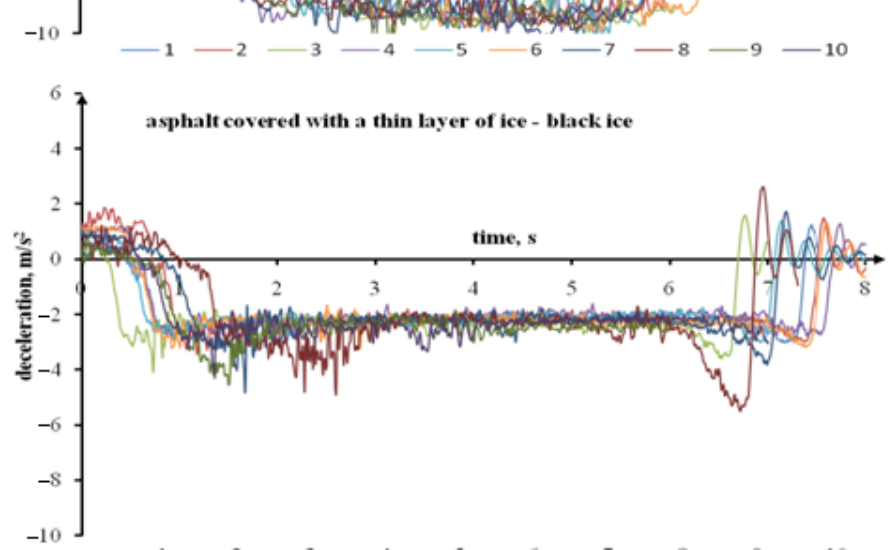
Figure 2. The Ford Transit’s deceleration during rapid braking on a dry surface, a wet (after rain) asphalt surface, and a surface covered with a thin ice layer with the initial speed of approximately 50 km/h.